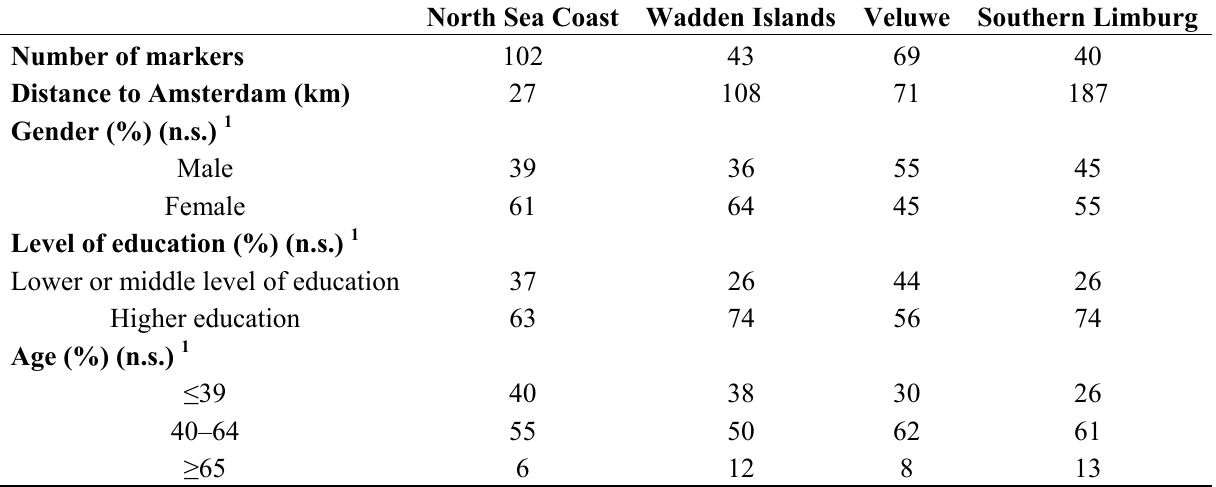
Table 2. Number of national markers, distance to Amsterdam and background characteristics of respondents by nature